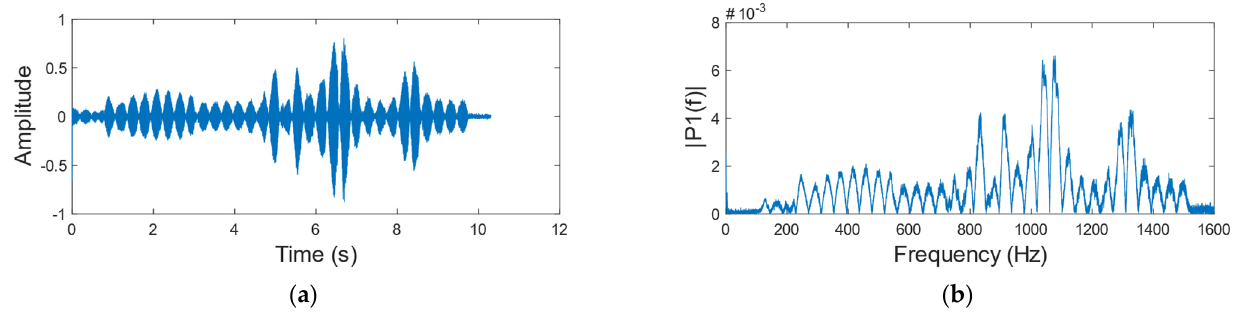
Figure 5. Reconstructed sinusoidal signal when a paper cup is the vibration object. ( a ) Time domain diagram. ( b ) Frequency domain diagram.